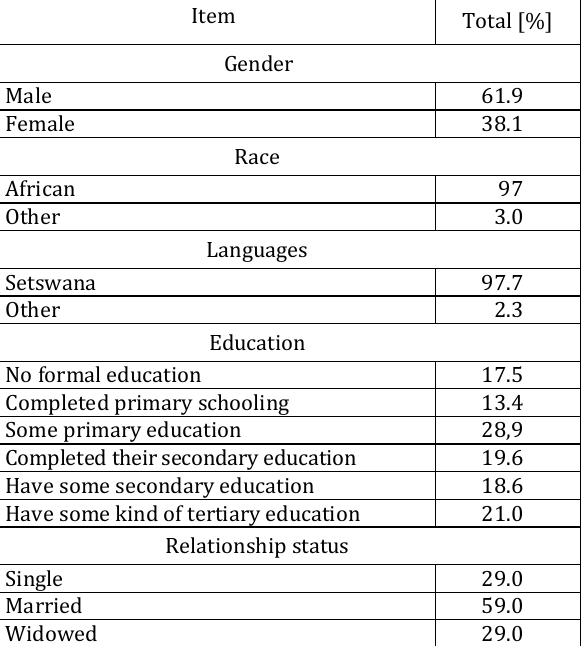
Table 1. Demographic characteristics of the